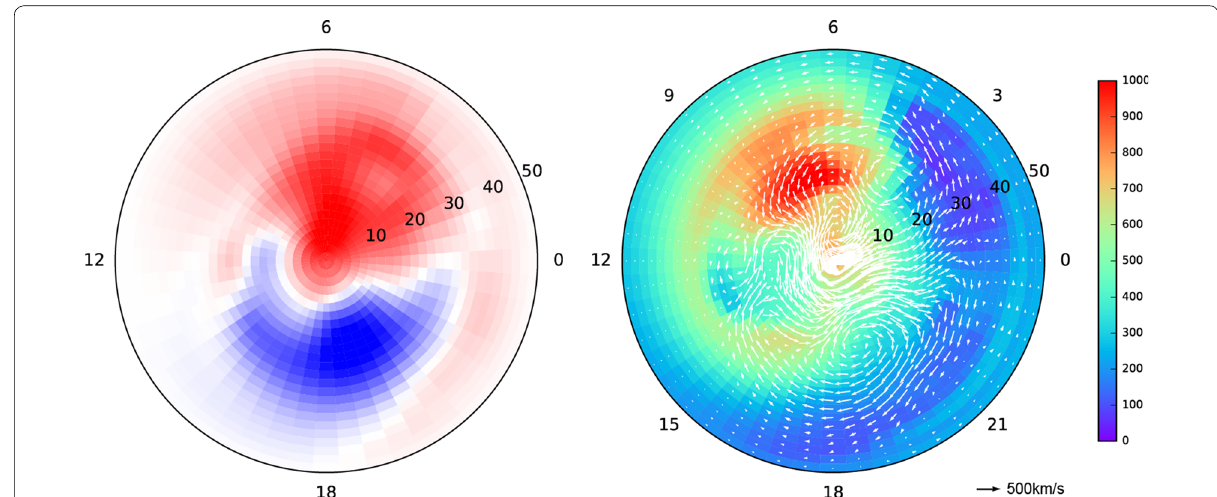
Fig. 13 The estimated stream function (left) and drift velocity distribution (right) on March 27, 2017, at 10:20 UT. In the right left panel, the esti‑ mated drift velocity distribution is shown with white arrows and the uncertainty of the drift velocity is shown with color